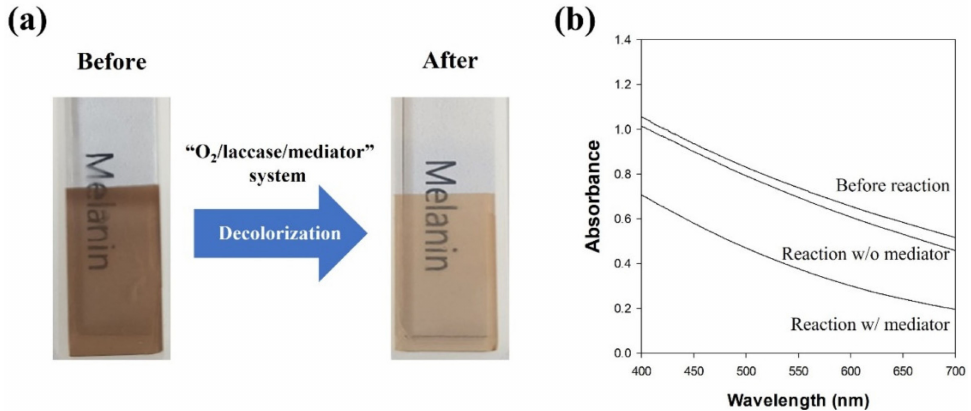
Figure 6. ( a ) Photo images and ( b ) spectrum of the melanin/cellulose films before and after the decolorization reaction by LMS using laccase from M. thermophila and